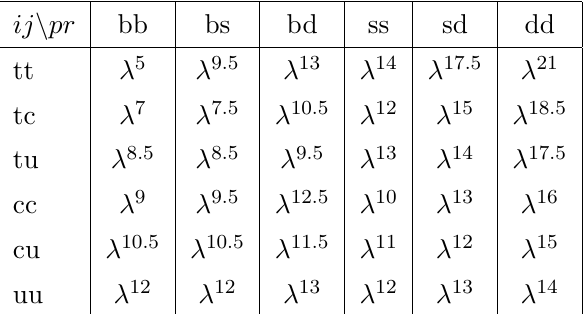
Table 8 . Estimates for the Yukawa and CKM suppression ( ’ V ip between operators containing ( q in the left column, and pr in the top